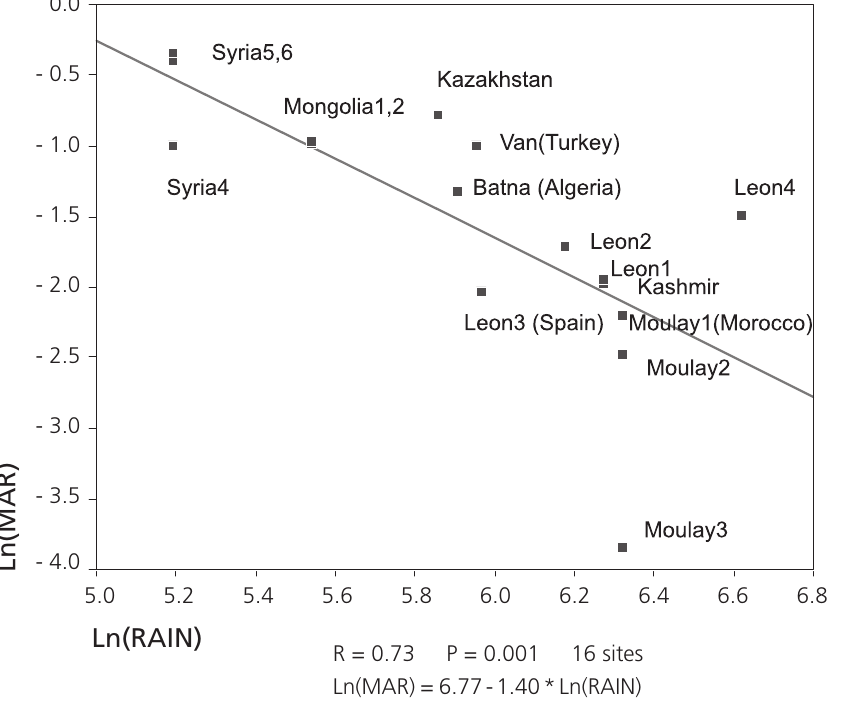
Fig. 3. – Linear relationship between prevalence of the nema- tode Marshallagia marshalli and rainfall in 16 surveys in steppe. (Ln: neperian logarithm, R: regres- sion coefficient and P probability of type 1